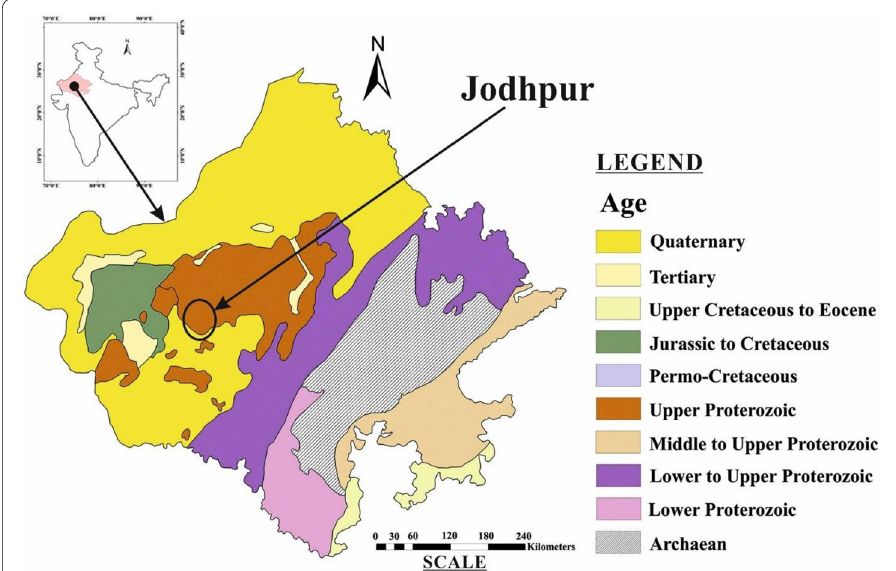
Fig. 1 Geological map of Jodhpur district, Rajasthan, India. (modified after